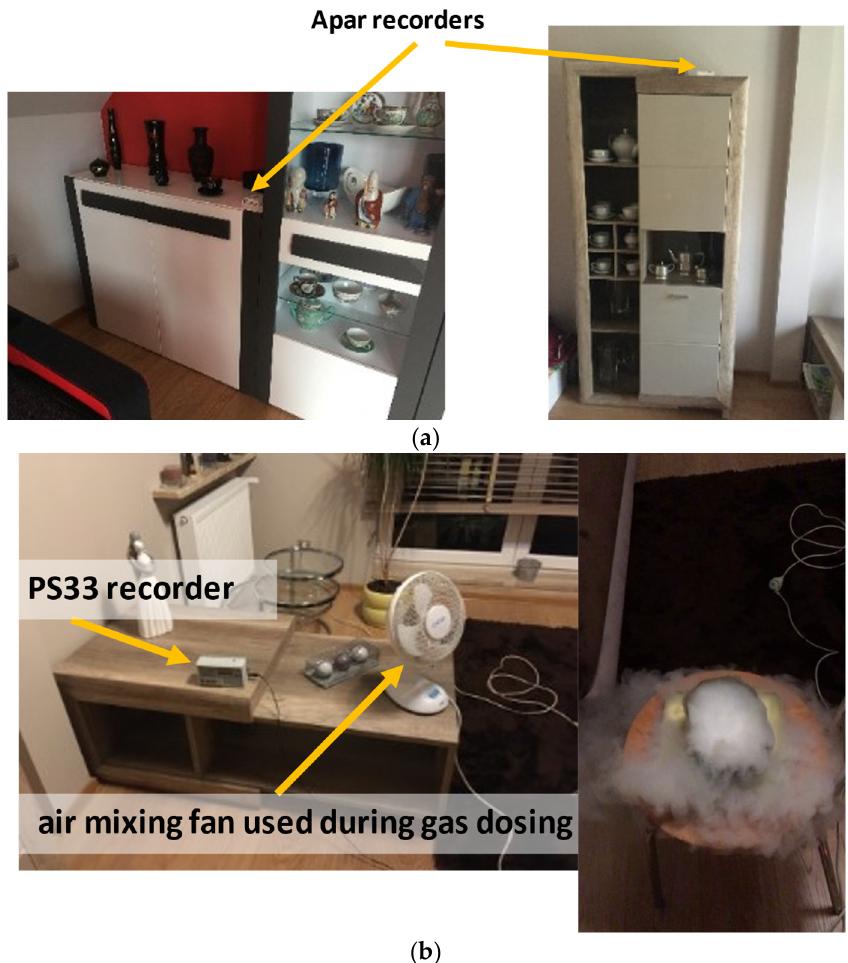
Figure 2. Location of measurement equipment ( a ) for temperature and humidity measurement; ( b ) for CO 2 measurement; moment of dosing tracer gas is presented.